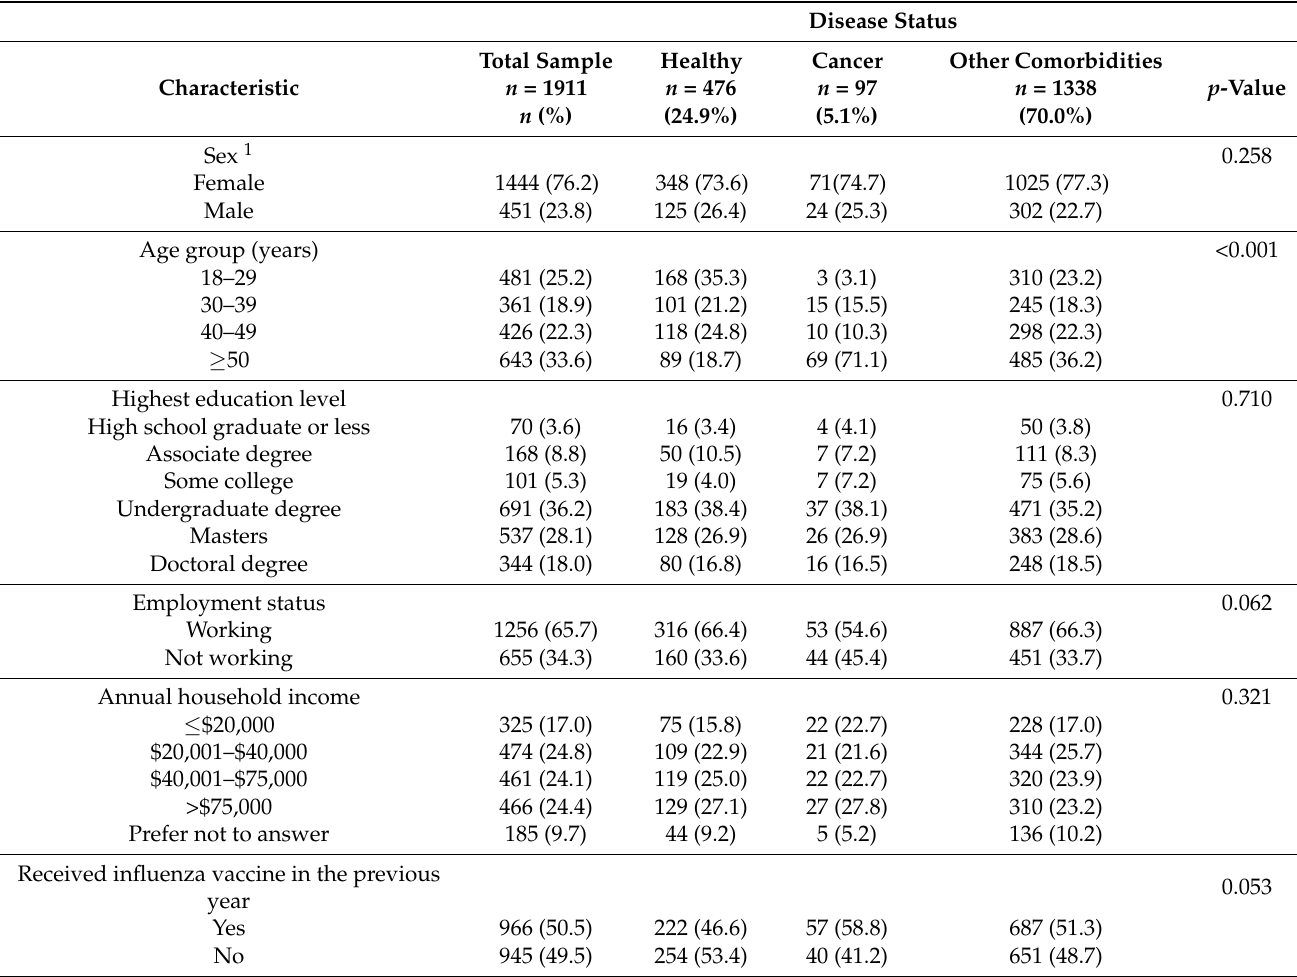
Table 1. Descriptive characteristics of study sample by disease status among adults living in PR ( n = 1911).